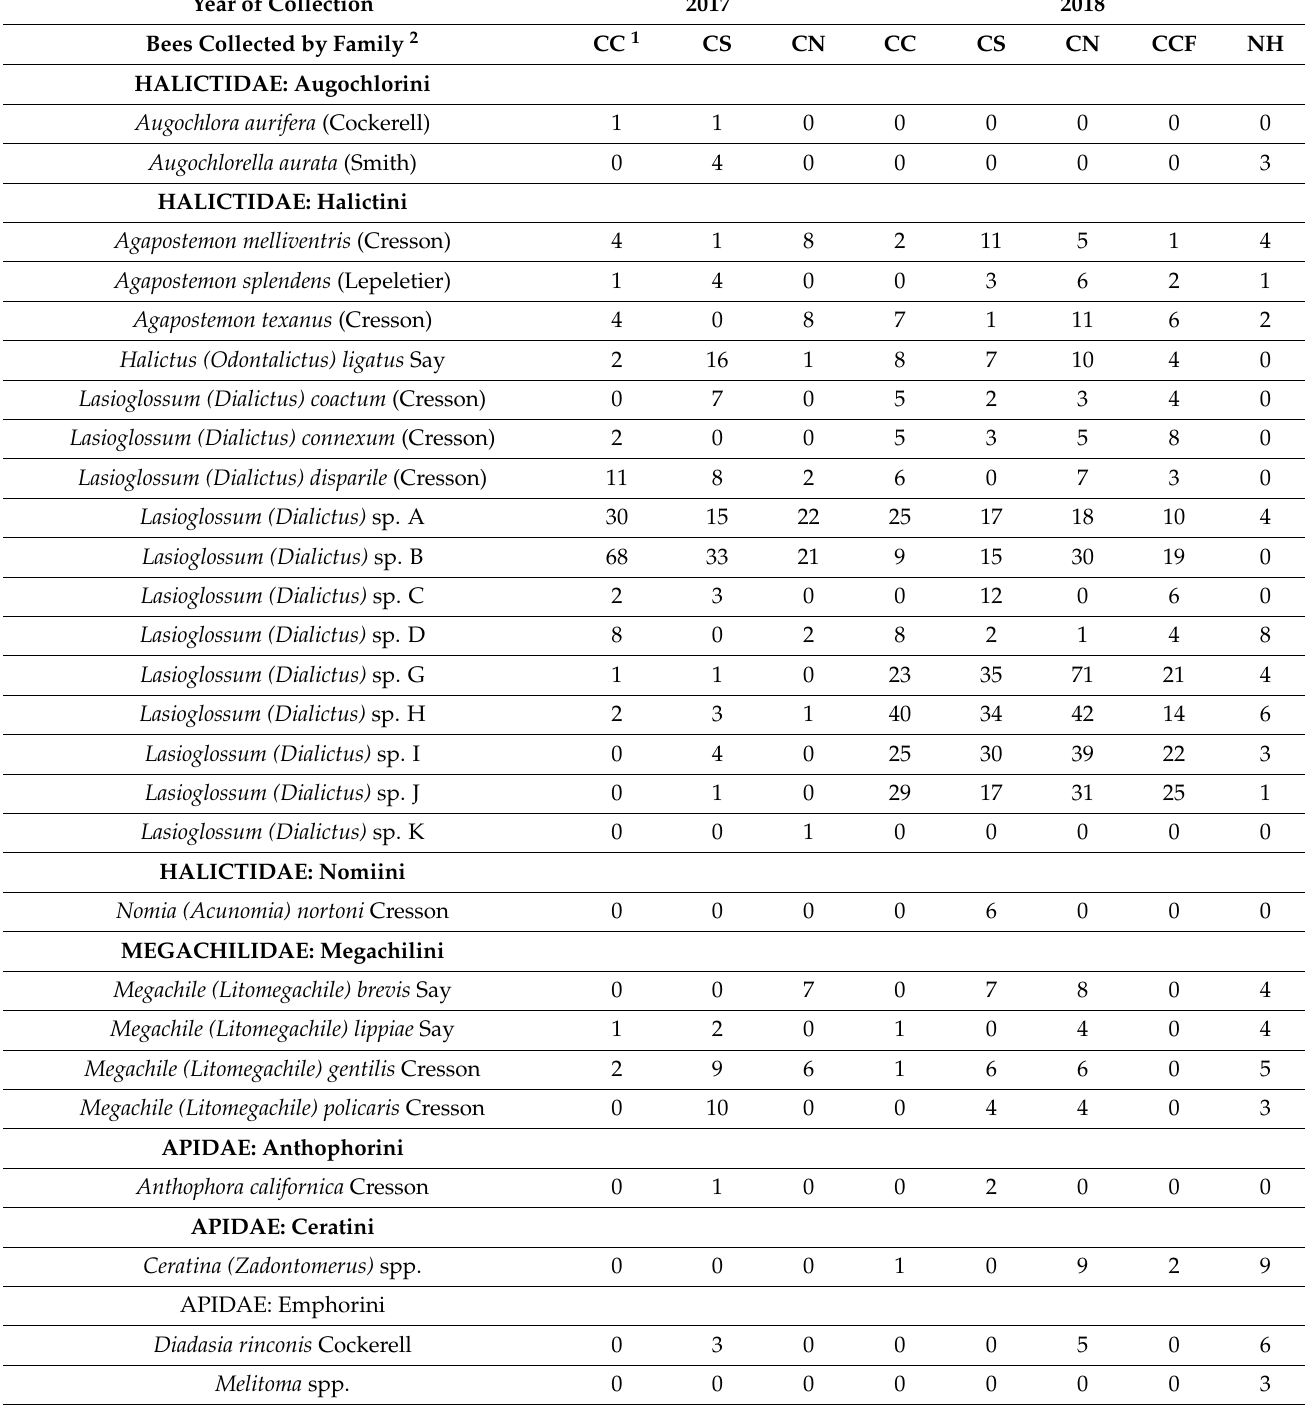
Table 1. The Number of native bees species collected at different crop-crop and crop-semi-natural habitat interfaces in a large-scale cotton